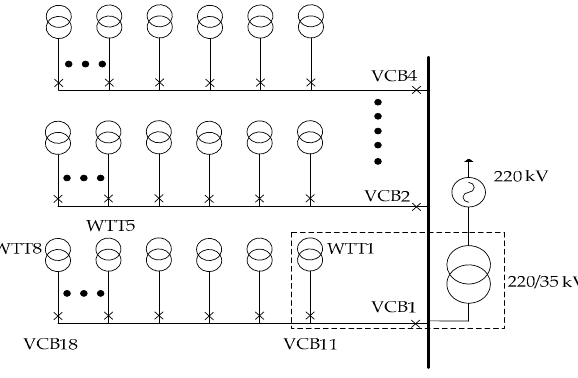
Figure 1. Simplified diagram of the investigated offshore wind farm (OWF).